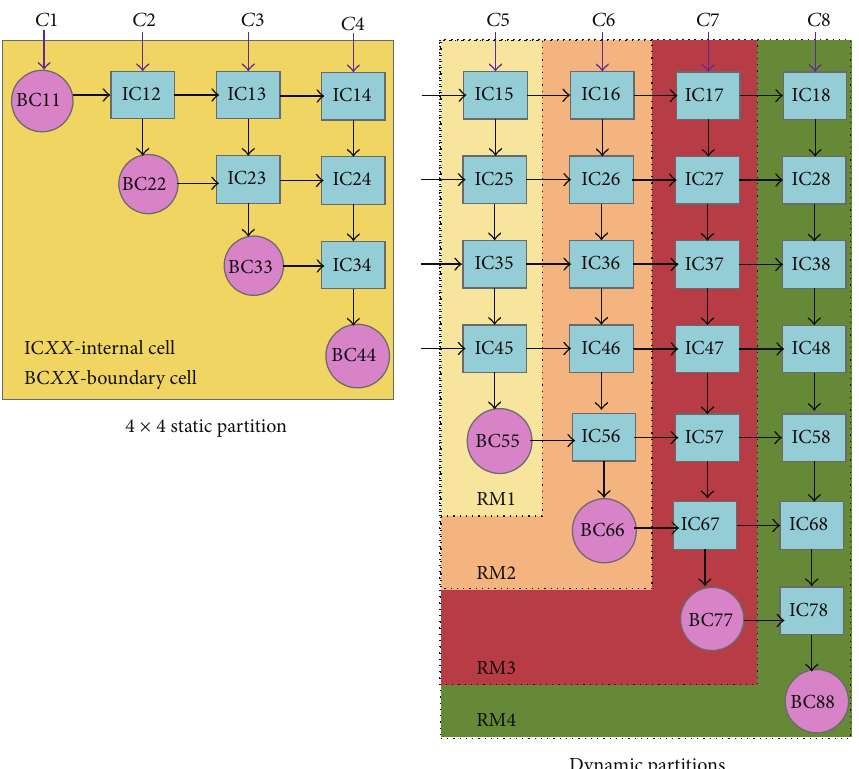
Figure 2: Block diagram representation of module based partial reconfiguration for the scalable QRD core.